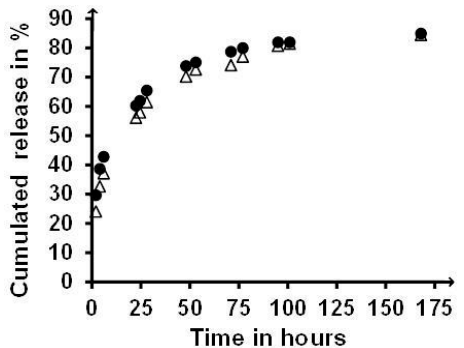
Figure 9. Comparison of the cumulated release profiles of the methylene released from COP50 0.1 ( ∆ ) and PNAGA 0.1 ( ● ) (gels from 6% polymer solutions) at 37 °C as determined by Ultraviolet (UV) spectroscopy at 665 nm (see the experimental section).